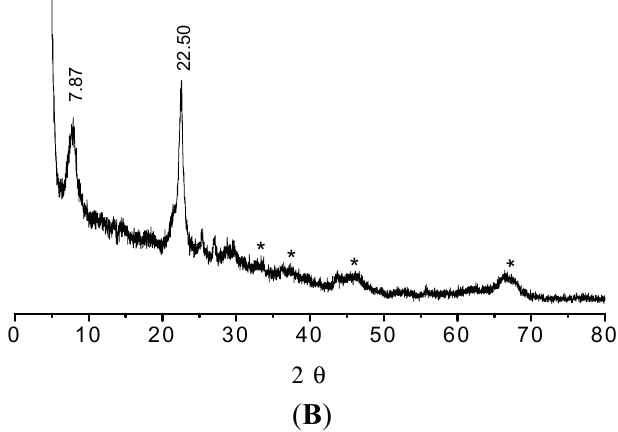
Figure 1. ( A ) X-ray diffraction patterns of the zeolites: (a) ZSM-12; and (b) MCM-22. ( B ) X-ray diffraction patterns of the Beta type zeolite. The reflexes due to the γ -Al 2 O 3 phase are marked by asterisks.